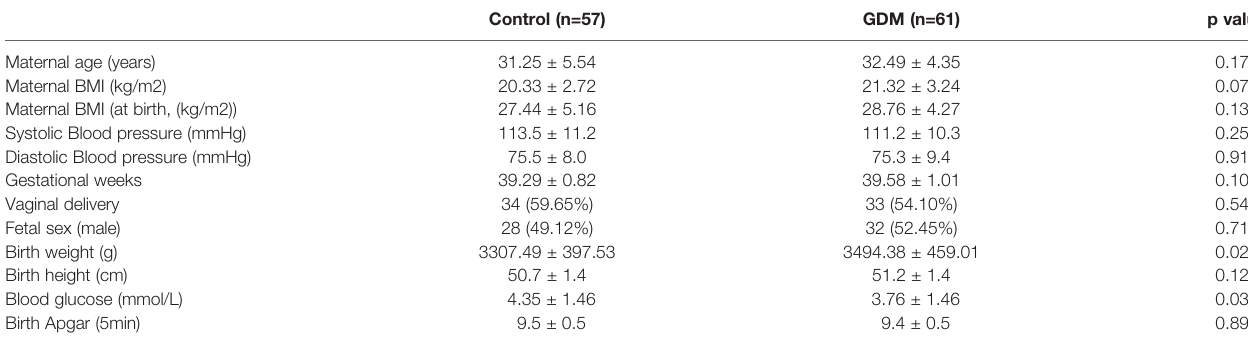
TABLE 1 | Baseline characteristics of study